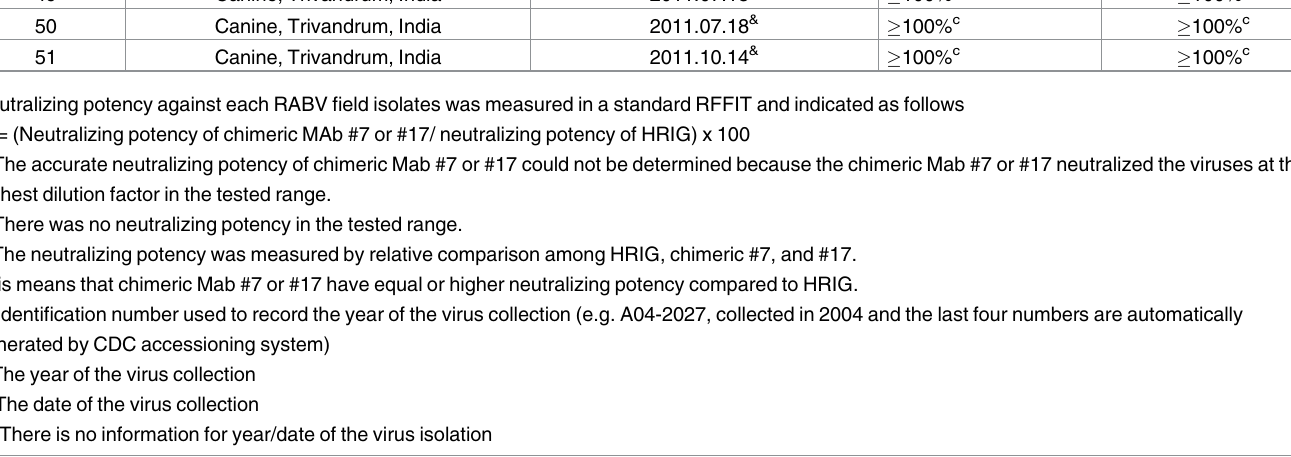
The residues crucial for binding chimeric mAbs MAbs#7 and #17 were identified by in vitro escape experiment. The amino acid variants that were identified as key binding epitopes of chi- meric MAb #7 in the escape mutant studies were detected in 68 (6.6%) sequences in a previous report [30]. Although R333K/N/Q containing isolates were detected in several bat lineages from the Americas, there was no R333W or R333L isolates. The key binding site for chimeric MAb #17, antigenic site I (KLCGVL), is highly conserved [21]. In a previous report [21], the glycine at position 229 was conserved in 99% of isolates. Three variants displayed different amino